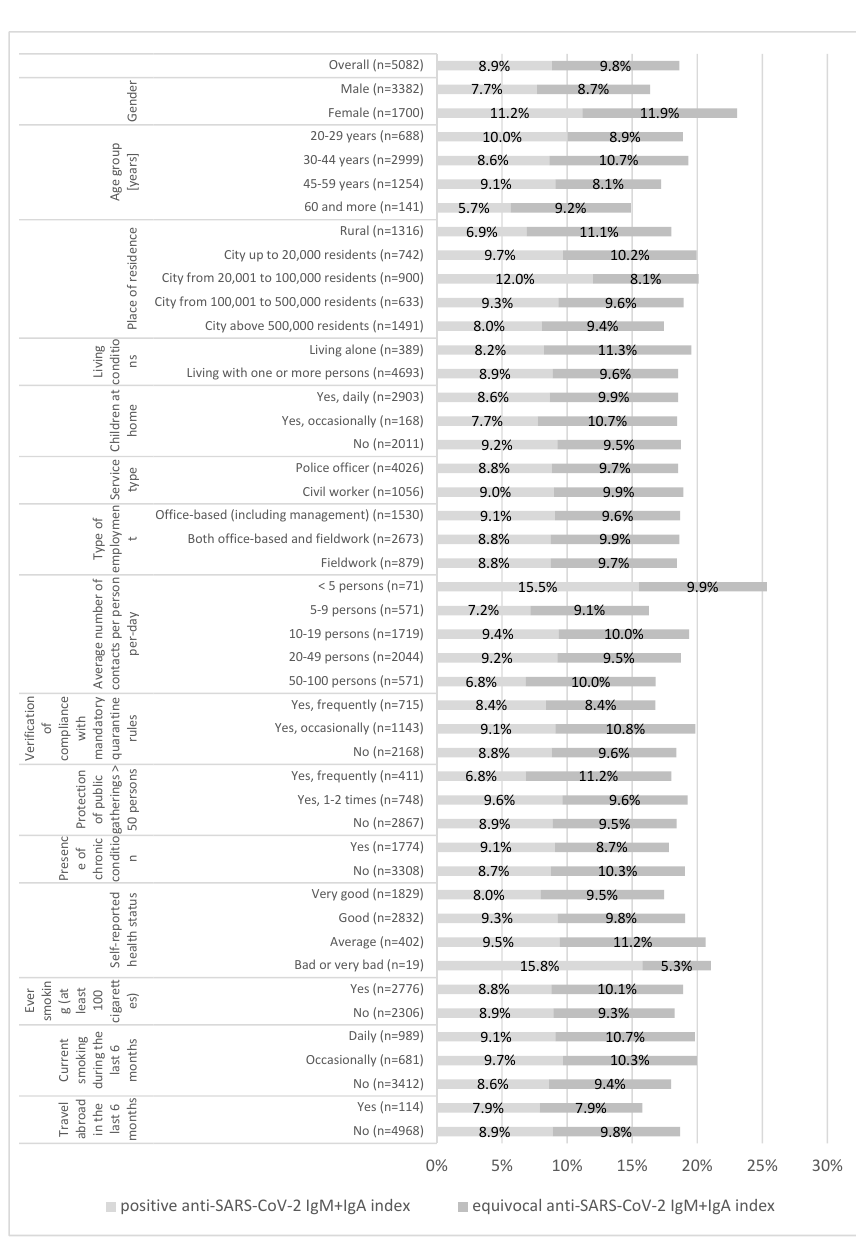
Figure 1. The prevalence of positive and equivocal anti-SARS-CoV-2 IgM+IgA index among 5082 police employees from Mazowieckie Province, Poland, presented by the personal and occupational characteristics.